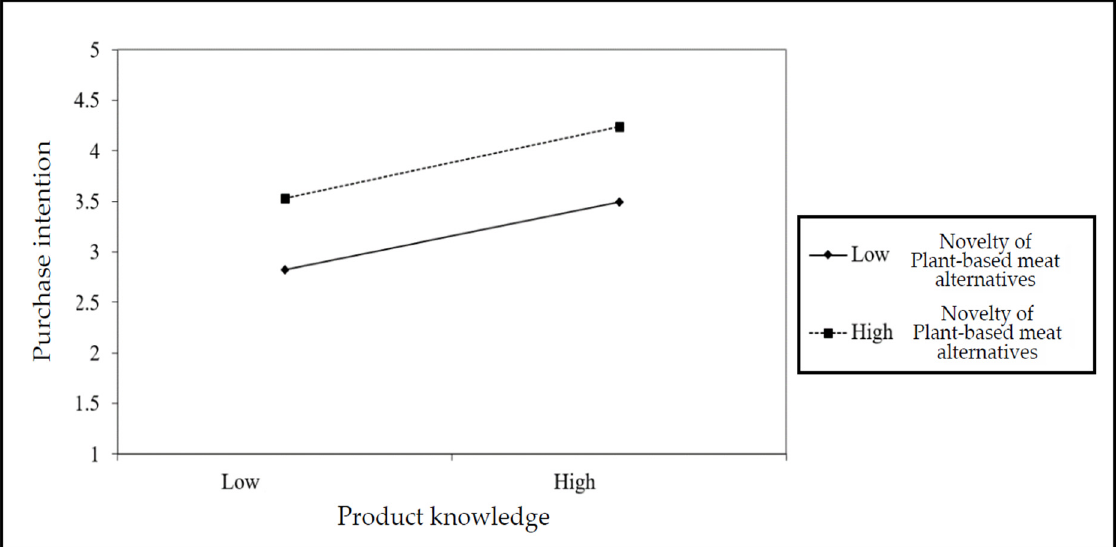
Figure 3. The interactive effect of product knowledge, purchase intention, and Novelty of Plant-based meat alternatives.